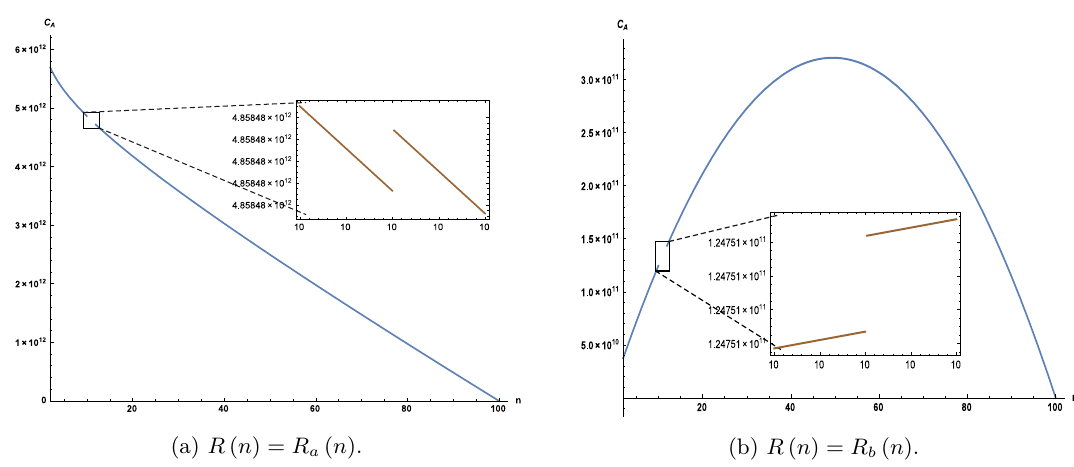
Figure 11. Complexity plots of n -boundary island model for two choices of